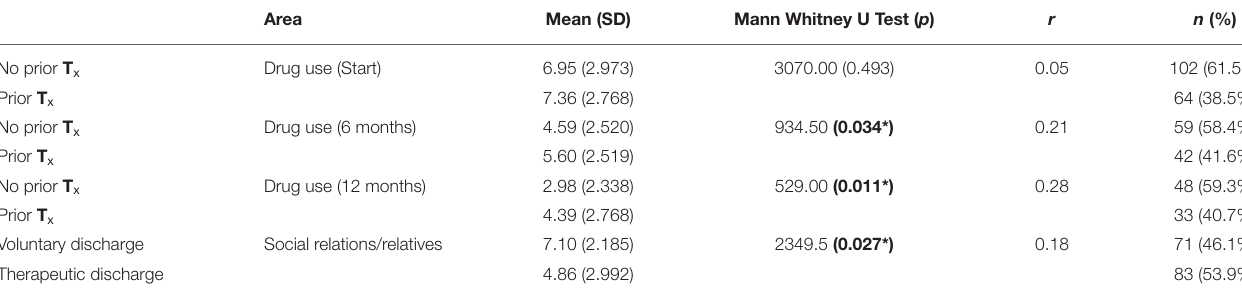
TABLE 7 | Differences by number of previous treatments, and type of